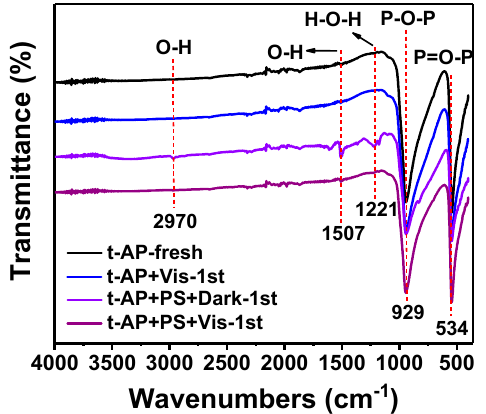
Figure 5. Fourier transform infrared spectra of Ag 3 PO 4 .